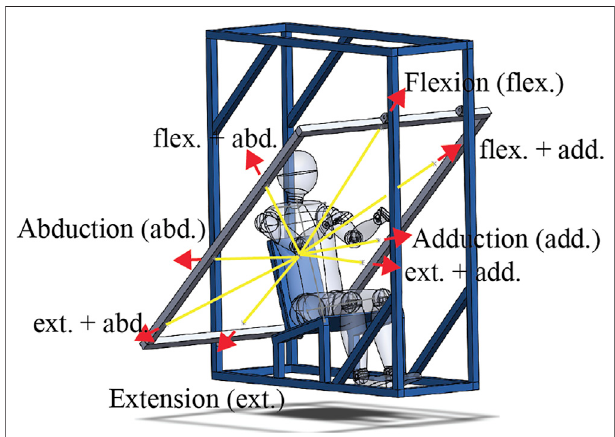
FIGURE 2 | Illustration of the spatial tuning task rig with yellow lines indicating a partial path of the ropes used and the red arrows indicating the loading directions with their abbreviations labeled. The full path of the eight ropesusedstartedattheelbow fi xture,ranthroughapulleyontheframe aligned with the loading plane (shown in gray), which diverted the rope behind thesubject,whereitwentthroughasecondpulleyallowingittobeattachedto the release mechanism. At the end of each rope, there were two loops. One loop to be attached to the release mechanism such that when the weight was attached, and all eight ropes were held taught with the elbow at a speci fi c location. The second loop on one rope, referred to as the active rope, was attached to the weight. When the release mechanism (a sailing cleat) was opened, seven of the ropes became free, and the active rope was pulled by the now falling 8-kg weight. Note that the weight free fell 2 – 3 cm before engaging the active rope. Selecting the active rope before release allowed